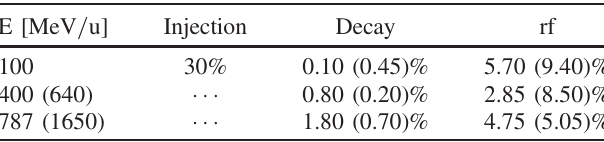
TABLE VI. Beam loss for 6 He ( 18 Ne).